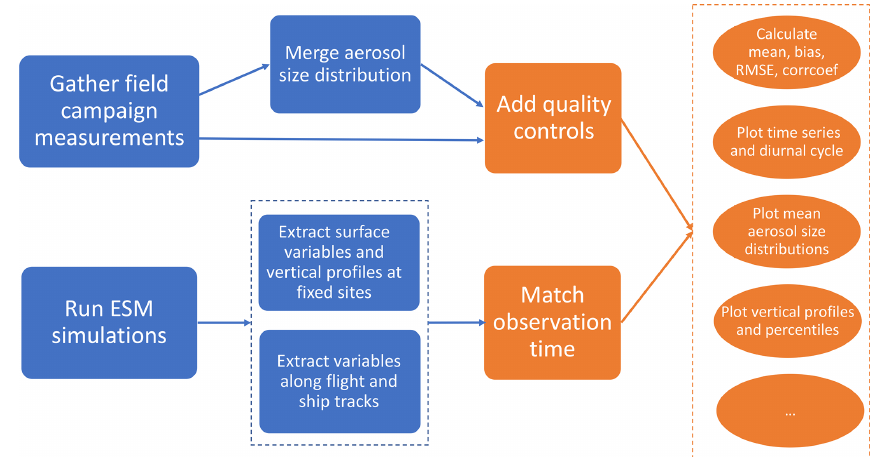
Figure 1. Workflow of ESMAC Diags. Data preprocessing and input are indicated by blue; diagnostics and plotting are indicated by orange.